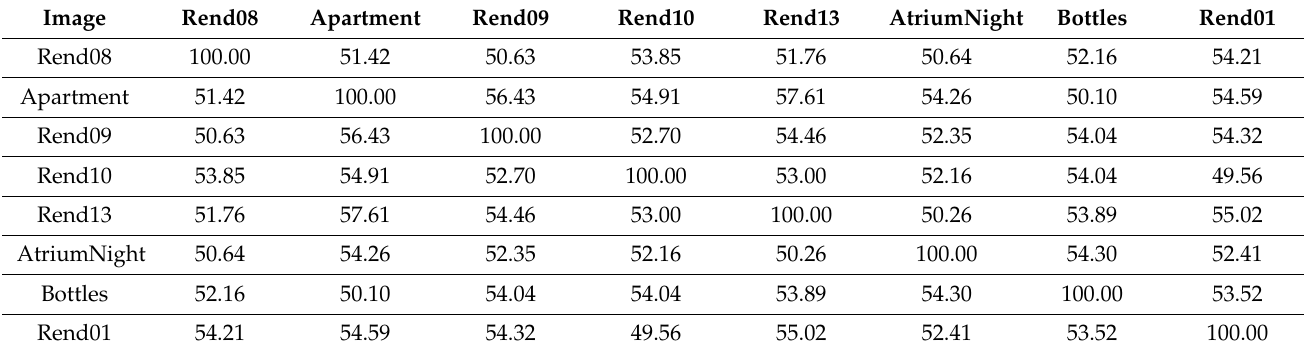
Table 1. NC s between generated zero-watermark images